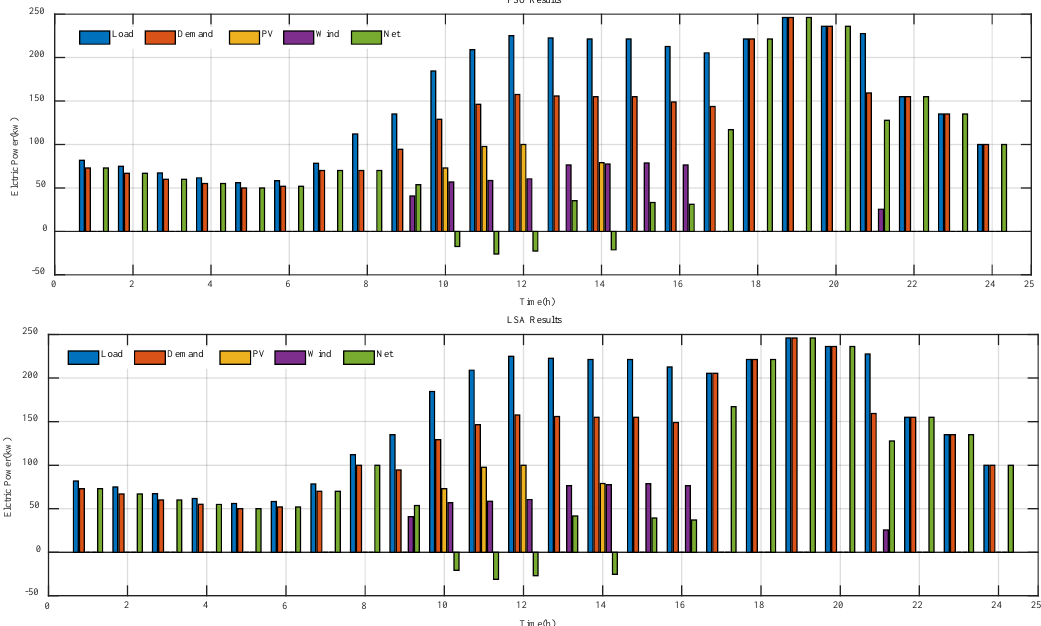
Figure 16. Power produced by EGs and exchanged power with upstream network in forth scenario (S4).